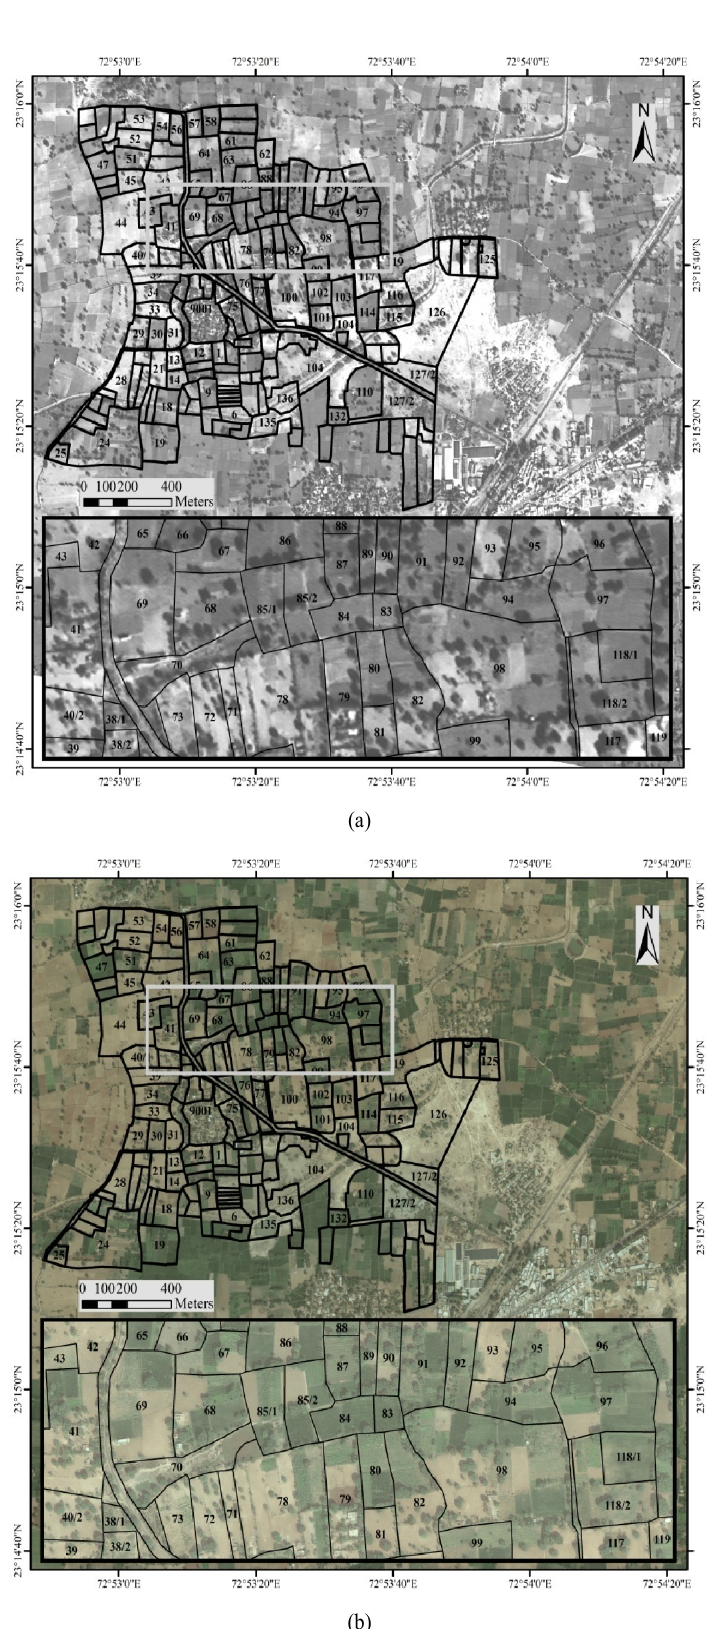
Figure 5. (a) Cadastral Parcel Derived from CARTOSAT-2 (b) Cadastral Parcels derived from